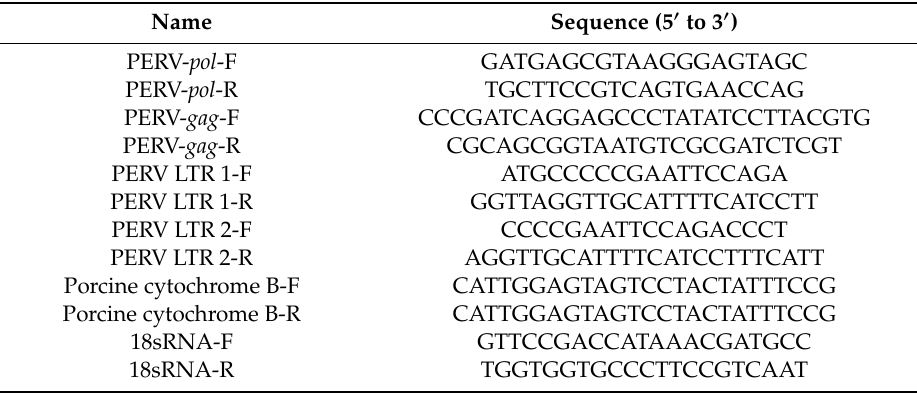
Table 2. Primers used for PCR and